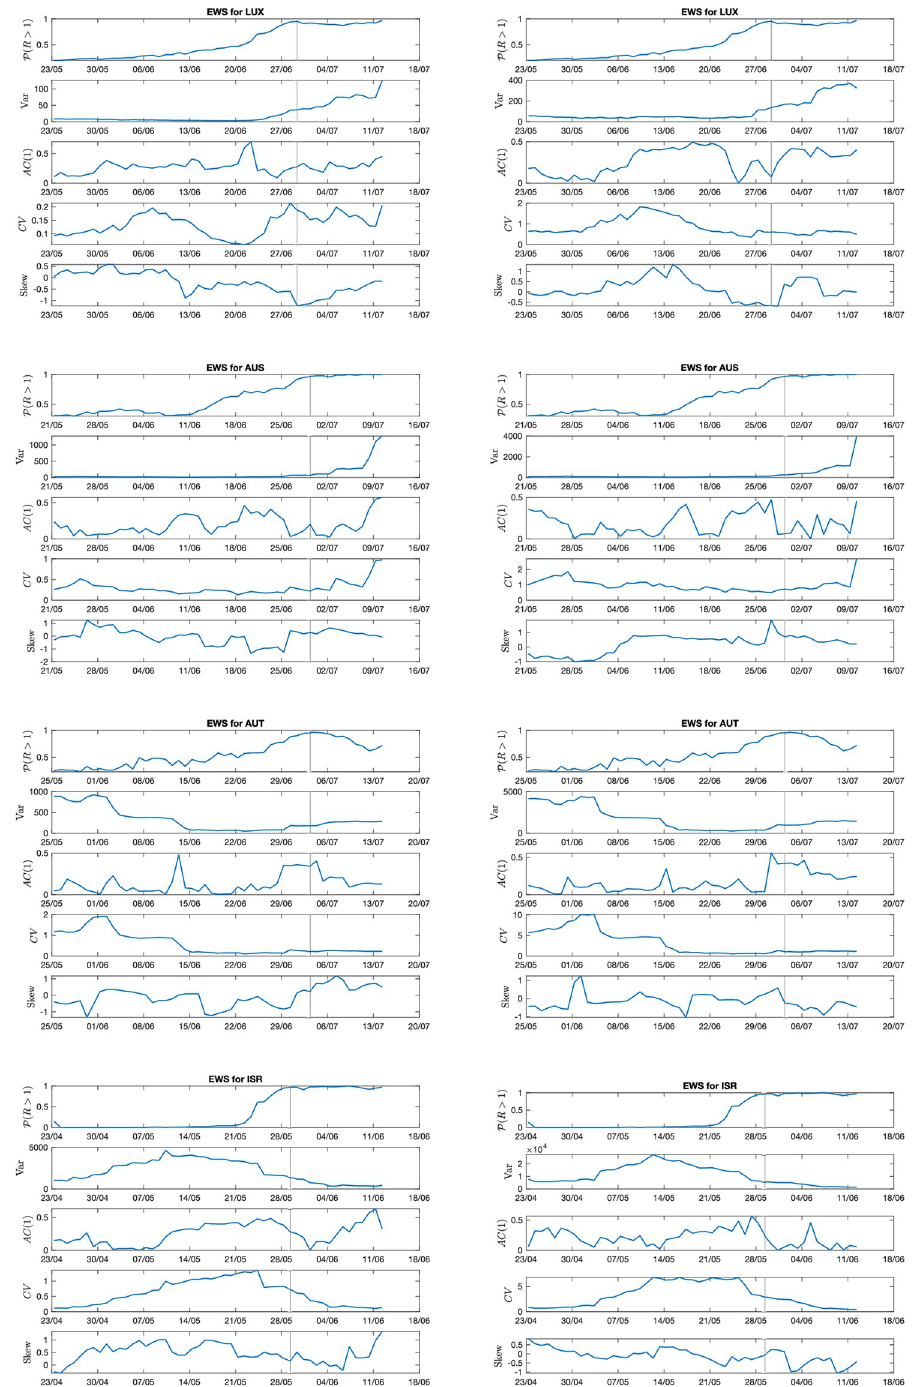
Fig 4. Evolution of EWS far from the transition point. Four example countries are shown: Luxembourg and Austria, with controlled features; State of Victoria (Australia), with small deviations from controlled features; and Israel that does not satisfy theoretical conditions. Considered EWS are the most common ones (variance, lag-1 autocorrelation, coefficient of variation, skewness). In addition, to mark the approach to the transition, P ð R ð t Þ > 1 Þ from the Bayesian estimation (see Eq 5) is displayed. The vertical line reports the transition date. Left column: detrending method employed: Gaussian filtering. Right column: detrending method employed: ARIMA. Other countries are reported in S1